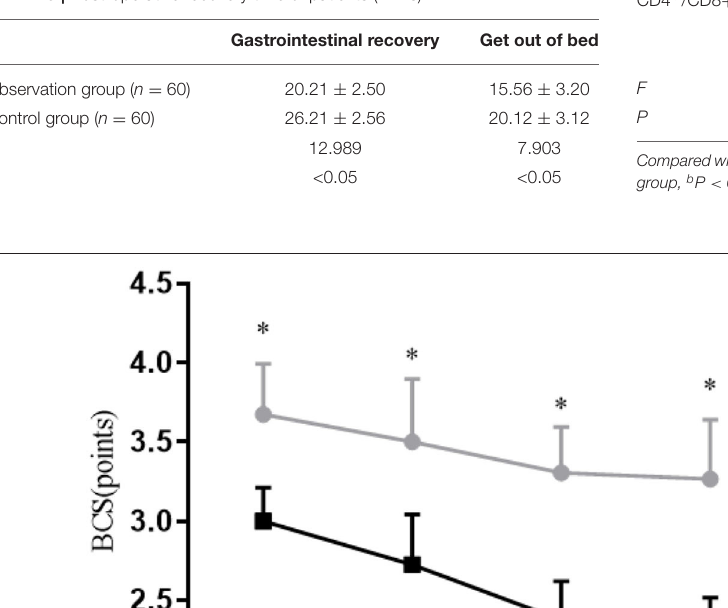
Frontiers in Surgery |